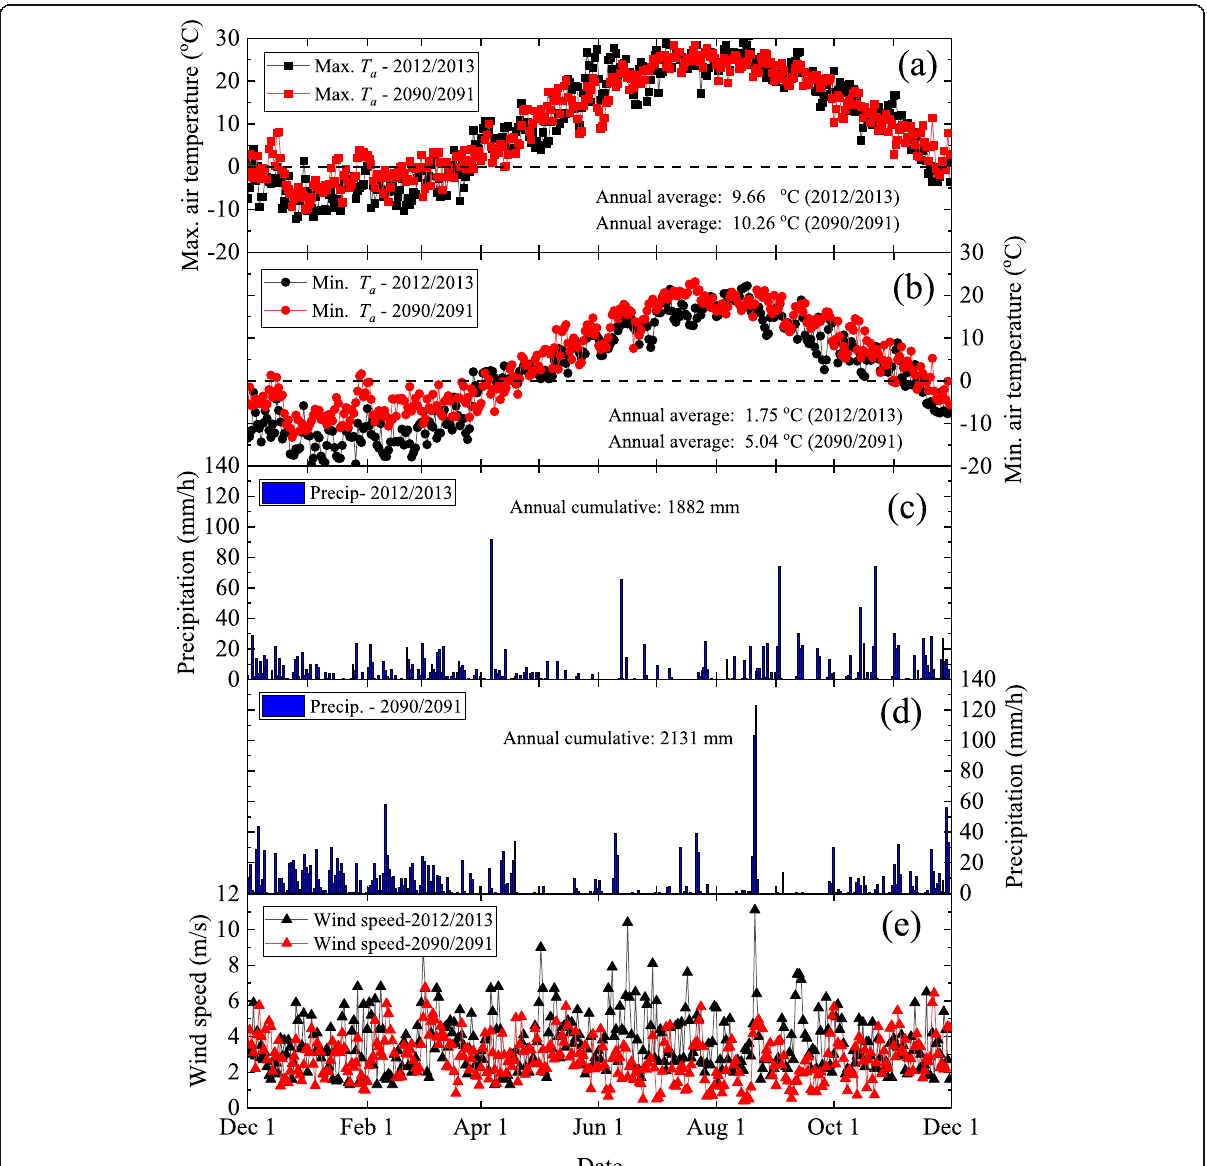
Fig. 4 Climate in the past and future at Nakayama Pass: ( a ) max. Air temperature; ( b ) min. Air temperature; ( c ) precipitation during 2012 – 2013; ( d